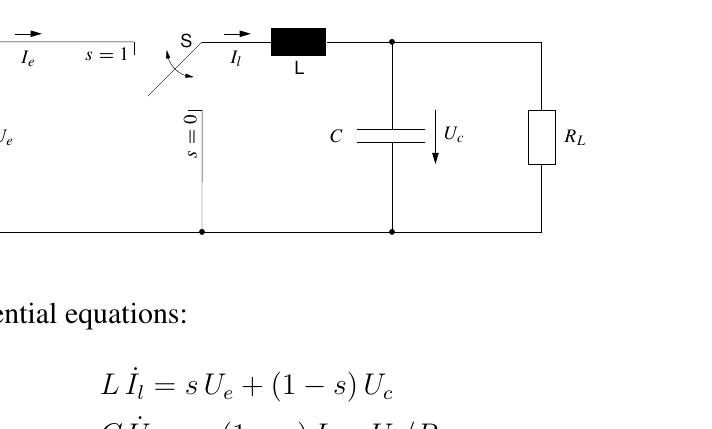
Figure 4. Lossless buck converter with resistive load.